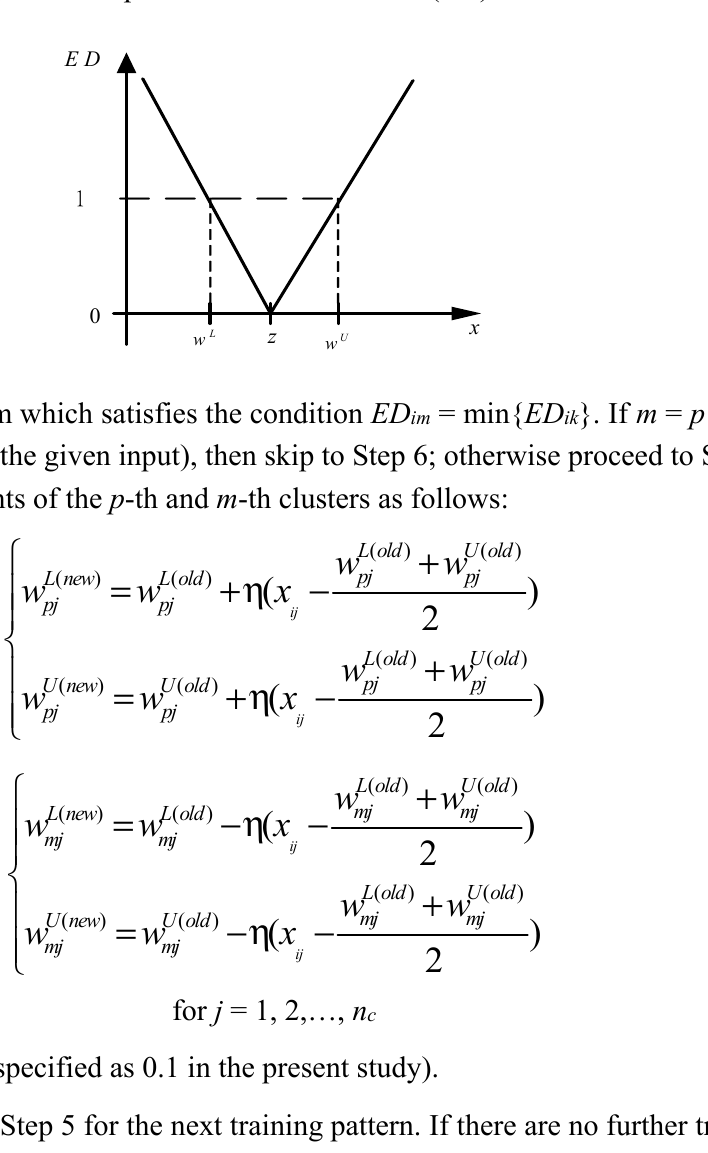
Figure 4. Proposed extension distance (ED)